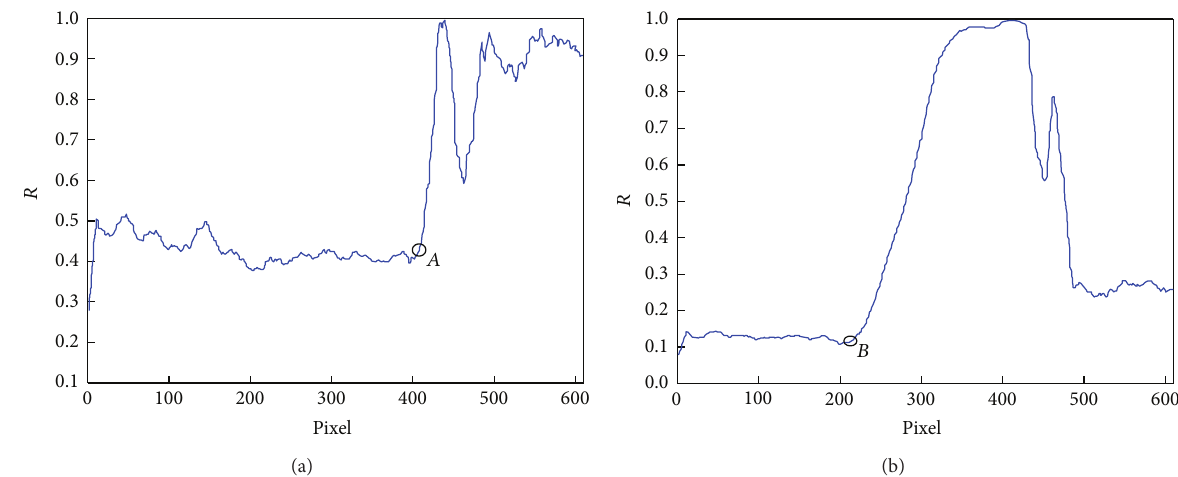
Figure 11: Distribution of the filtered 𝑅 with the horizontal position of the image.